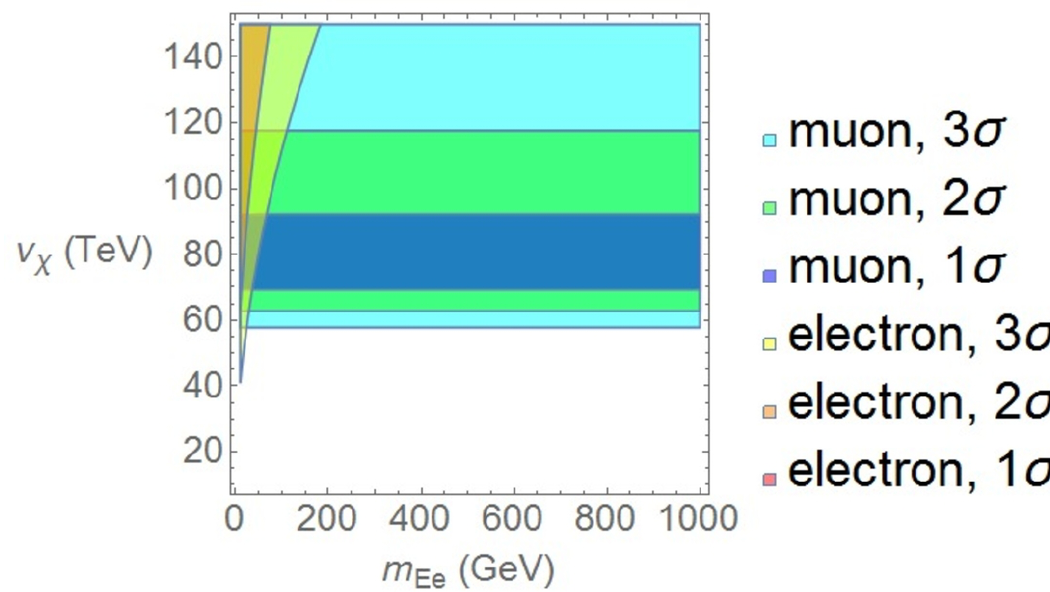
= m E = 500, m = 1000, Y + 1 (cid:22) (cid:28)